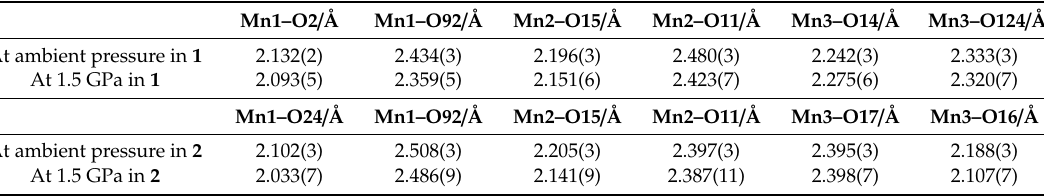
Table 2. Comparison of the bond lengths (Å) of the Jahn–Teller axes at ambient pressure and at 1.5 GPa for complexes 1 and 2